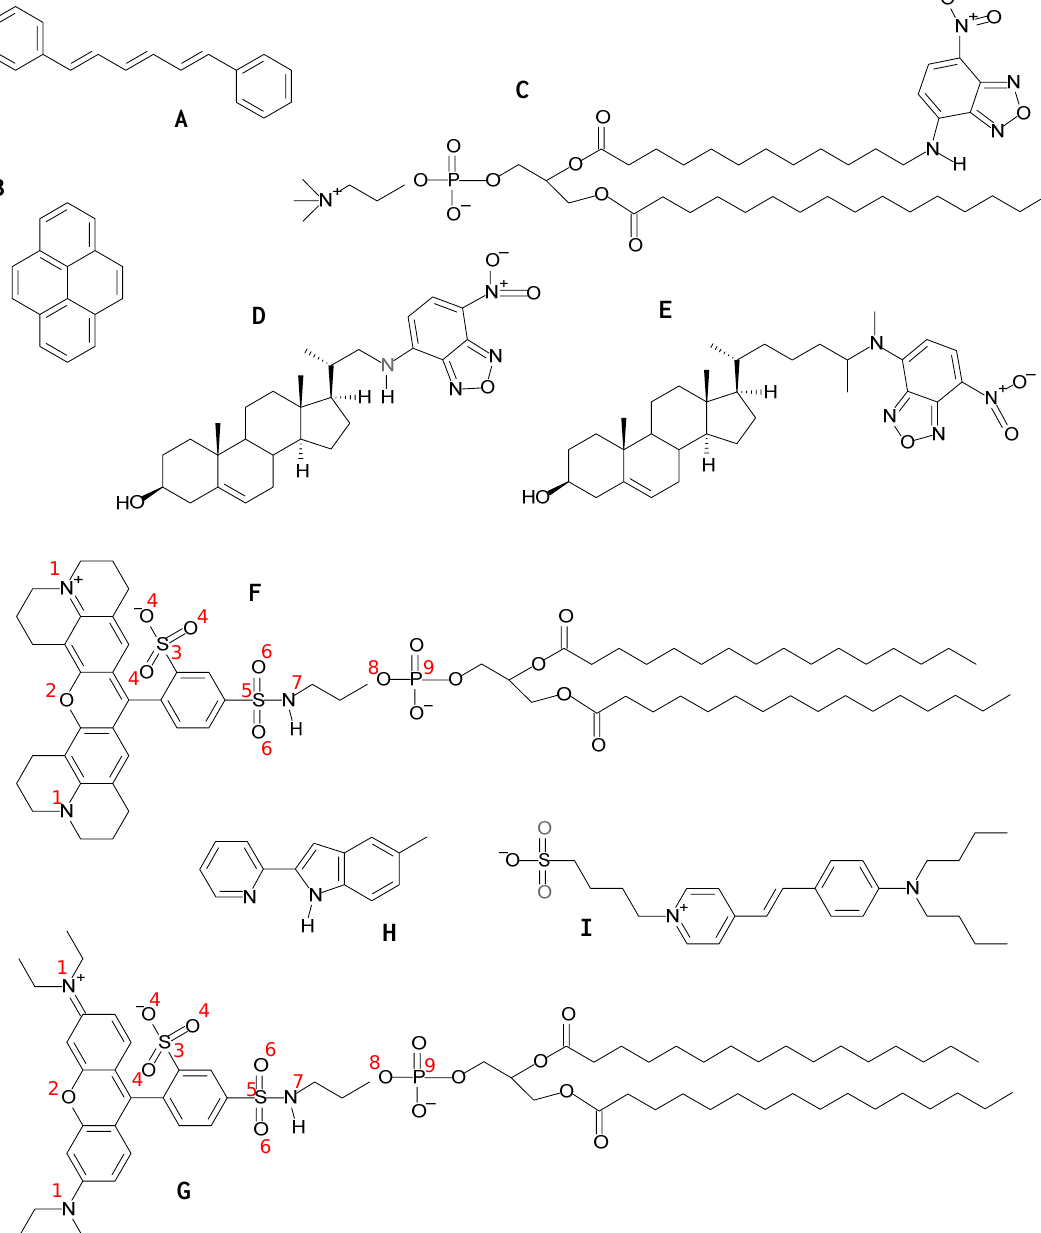
Figure 1. Structures of membrane probes mentioned in this article. ( A ) DPH; ( B ) pyrene; ( C ) C12-NBD-PC; ( D ) 22-NBD-cholesterol; ( E ) 25-NBD-cholesterol; ( F )